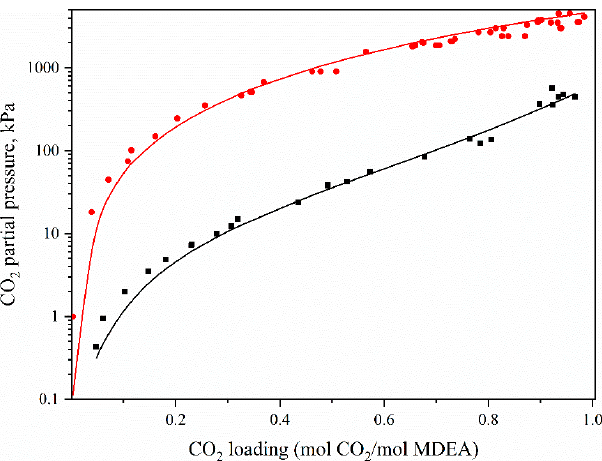
Figure 4. Comparison of the experimental data and calculated data for the CO 2 –H 2 O–sulfolane–MDEA system under different conditions. ■ , measured by Jou et al. [43], T = 313.15 K, MDEA mass fraction = 0.305, sulfolane mass fraction = 0.209; ● , measured by Jou et al. [43], T = 373.15 K, MDEA mass fraction = 0.305, sulfolane mass fraction = 0.209. The solid line represents the calculated data in this work.